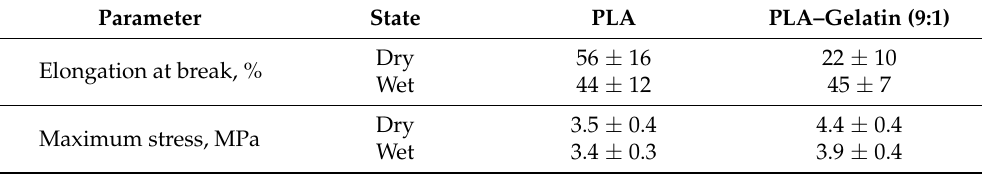
Table 1. The mechanical testing parameters of electrospun PLA and PLA–gelatin (9:1) mats. Parameter